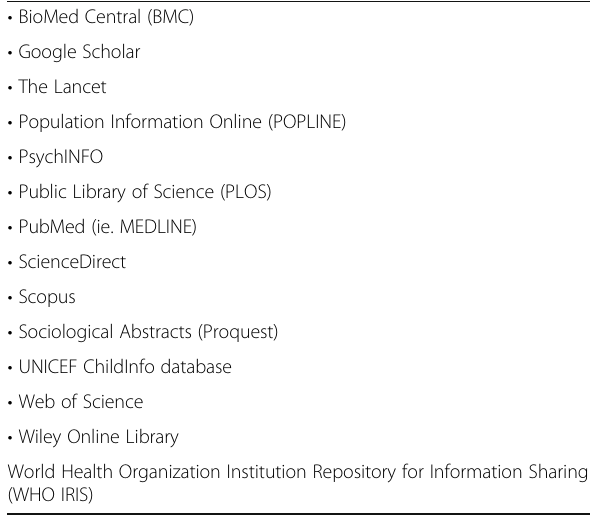
Table 1 Peer-Reviewed Literature Electronic Database Sources